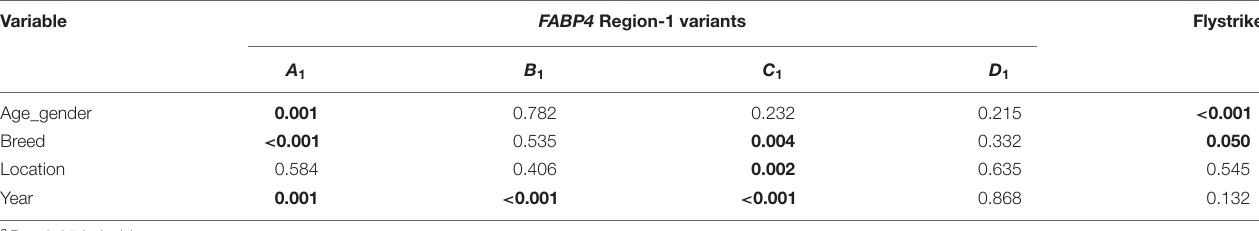
TABLE 2 | P -values a from Pearson Chi-square analyses exploring associations between the variables, each FABP4 Region-1 variant and flystrike occurrence. Variable